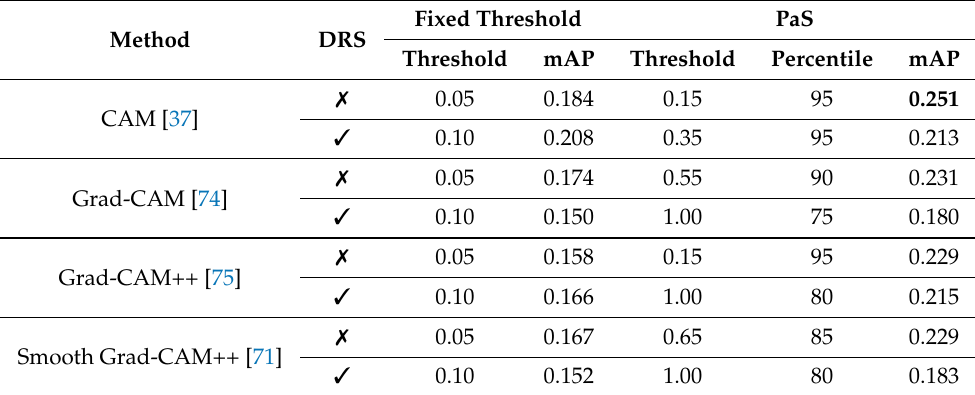
Table 6. Mean Average Precision of pseudo-GT (ArtDL 2.0) —The mAP is evaluated considering the CAM of the GT classes on the validation set. The use of percentile always yields better results than a fixed threshold and the best architecture is the configuration with ResNet-50, CAM, a threshold of 0.15, and the 95th percentile. The best-performing method is highlighted in